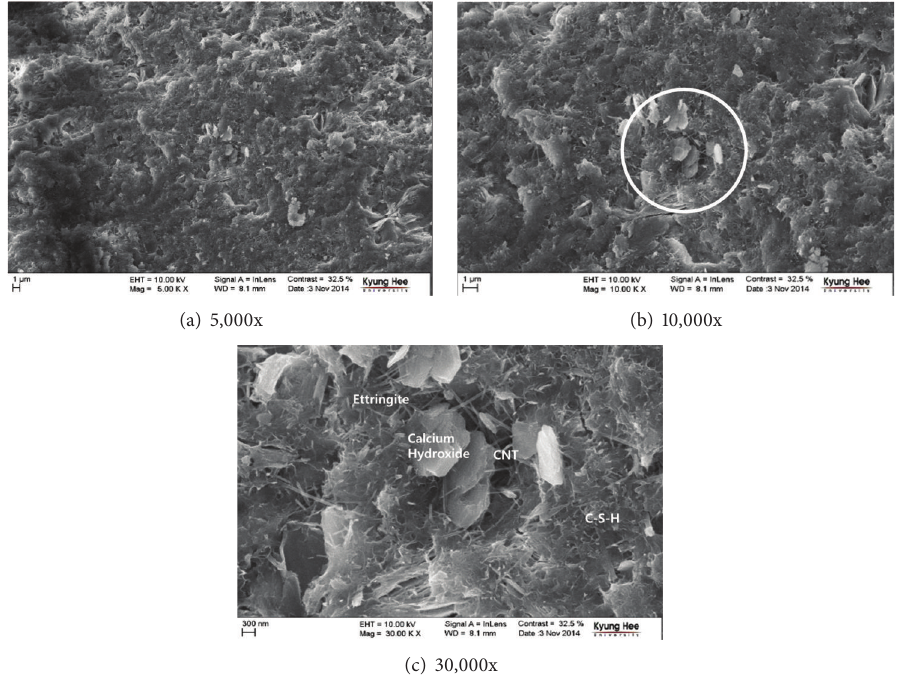
Figure 9: SEM images obtained for specimen